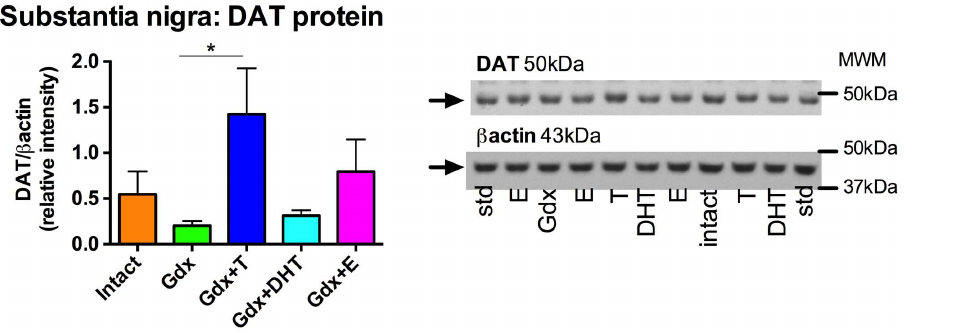
Figure 3. Effect of gonadectomy and sex steroid replacement on dopamine transporter protein in the substantia nigra of adolescent male rats. In the substantia nigra there was a trend for treatment group to change DAT protein (F=2.52, df = (4,41), p =0.056). Representative immunoblots of a subset of substantia nigra samples show DAT (50 kDa) and b -actin (43 kDa). A priori , planned comparisons, based on mRNA data, revealed that testosterone replacement increased DAT protein compared to the gonadectomised group. * p , 0.05, n=9–10/group. (MWM, molecular weight marker; std, internal standard).